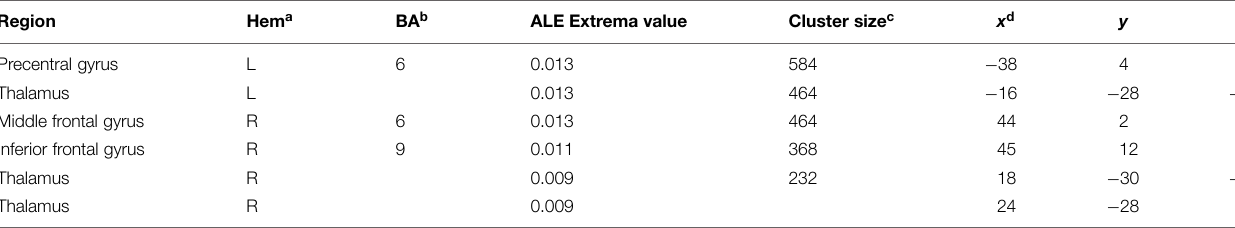
TABLE 5 | Regions showing consistent activations across fMRI studies of visuo-spatial creativity.